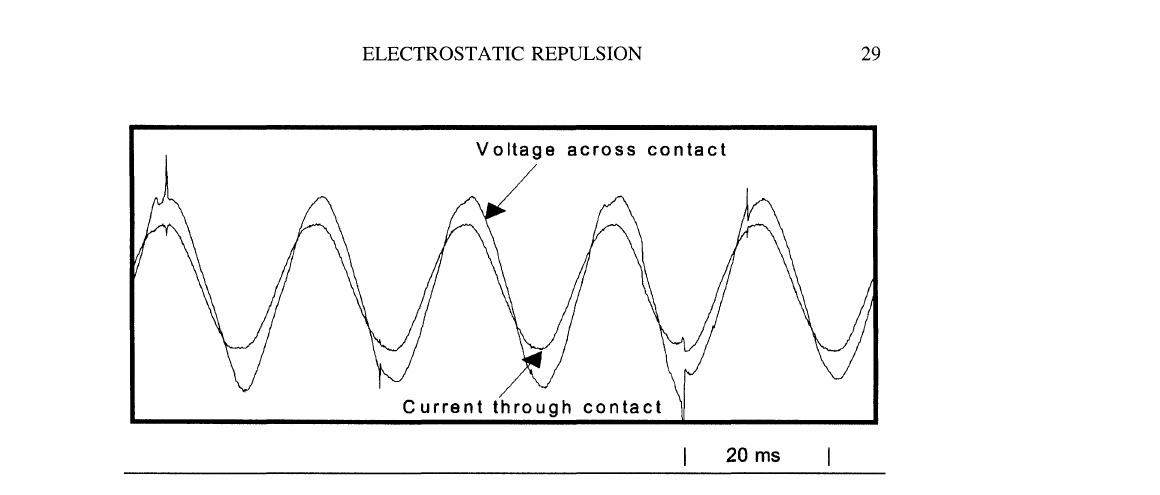
FIGURE 4 Current and voltage profiles traced across highly injecting hemispherical copper contacts. Note instability occurrence implying instant increase of contact resistance (in- creased voltage and reduced current). This could be related to spontaneous separation process across mating joints. Clamping force 0.2 N. Apparent contact area 0.5 mm 2. Current through contact 230 Arms, 50 Hz. Steady state peak voltage value across the junction 0.7